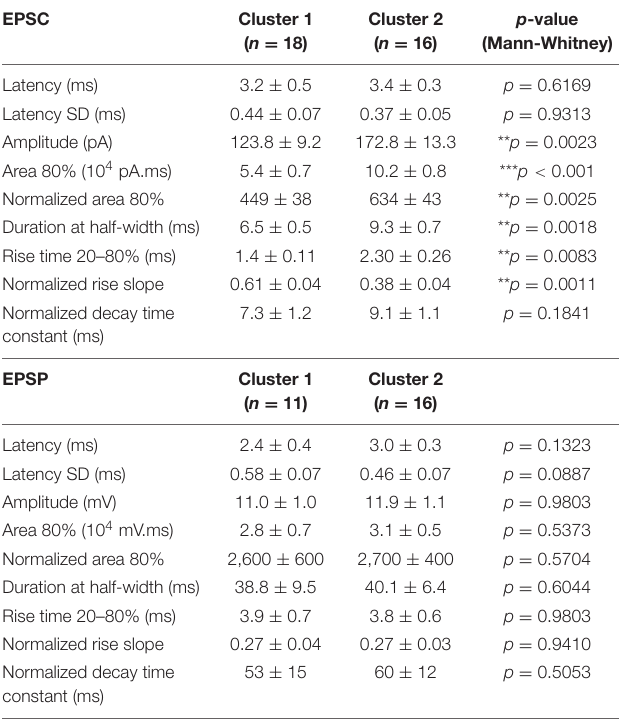
TABLE 4 | EPSCs and EPSPs properties in response to L2/3 FEF